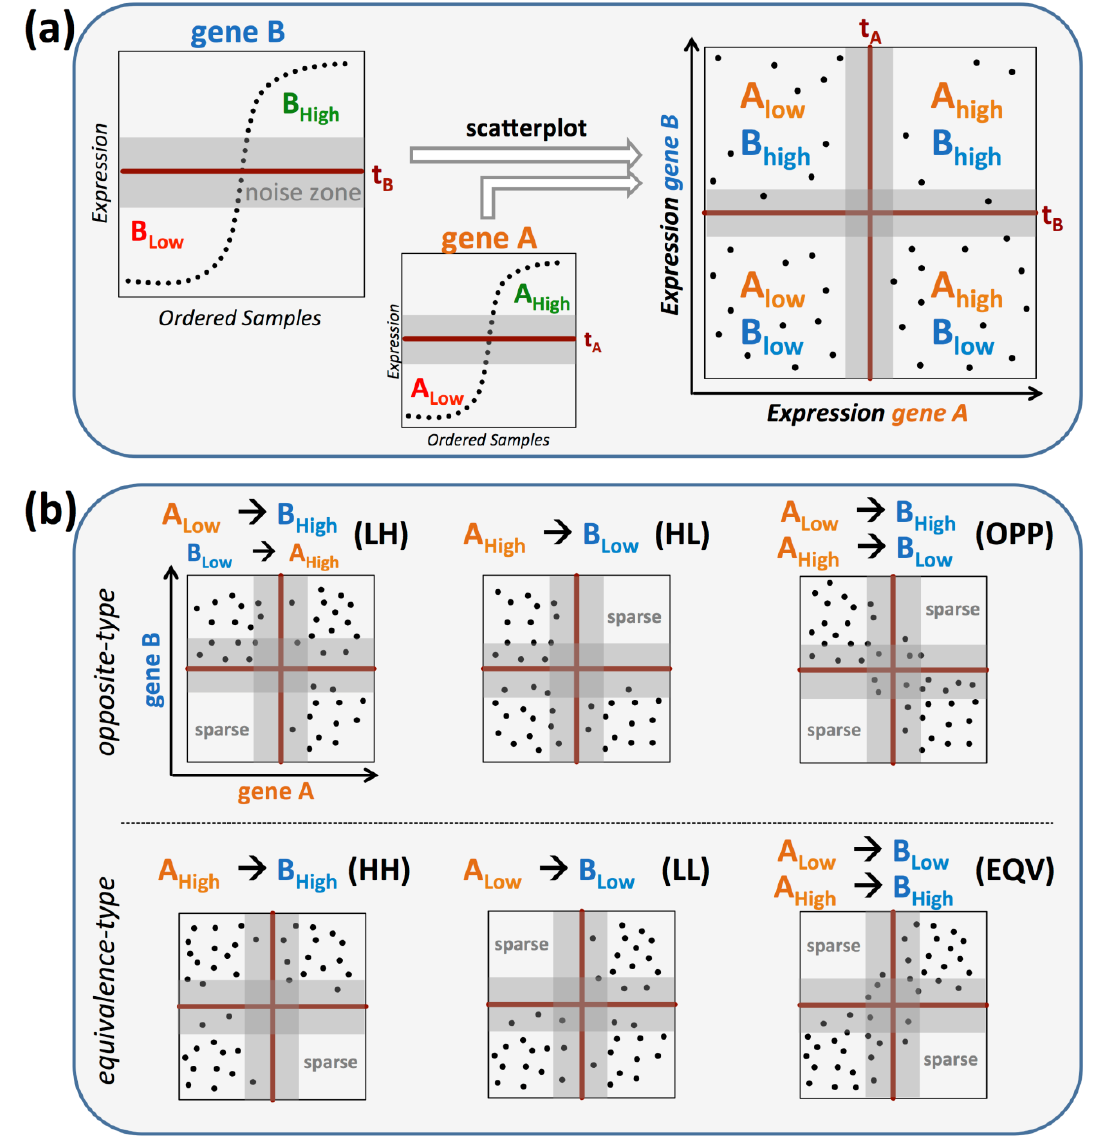
Figure 1: Boolean implications, definition and detection from pairwise gene relations.The ordered expression profiles of a pair of genes are divided into ‘low’ and ‘high’ expression levels by corresponding thresholds t . A paired scatterplot then yields four quadrants constituted by combination of the two genes and the two expression levels (panel a). Sparse quadrants indicate, depending on the positions, opposite type or equivalence type relationships between two genes (panel b). The abbreviations of the relations LH(Low-High), HL(High-Low), HH(High-High), LL(Low-low), EQV(Equivalence) and OPP(Opposite) are used throughout this